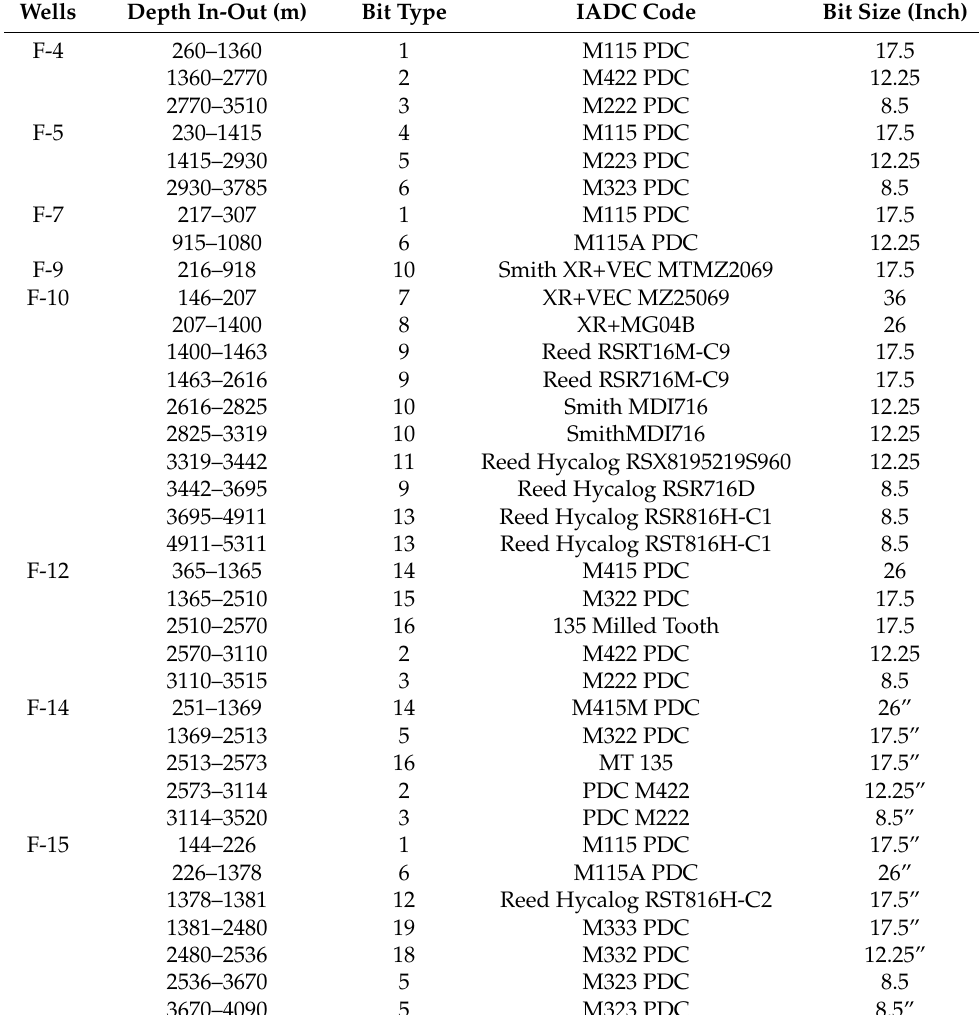
Table A1. Different drill bit utilized for drilling of Volve wells at different depths.